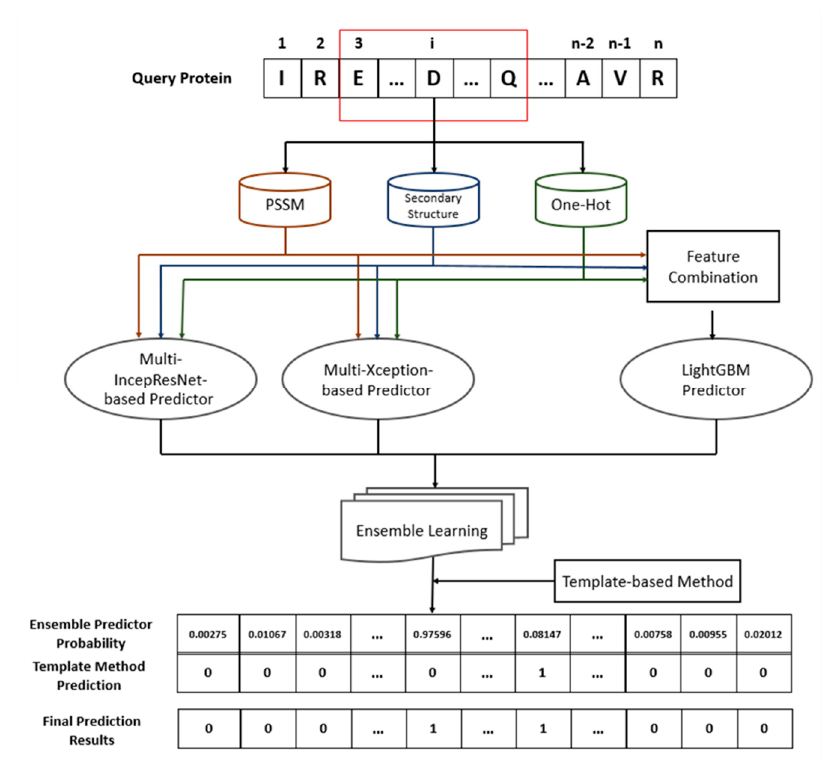
Figure 9. The architecture of the proposed ensemble prediction method.